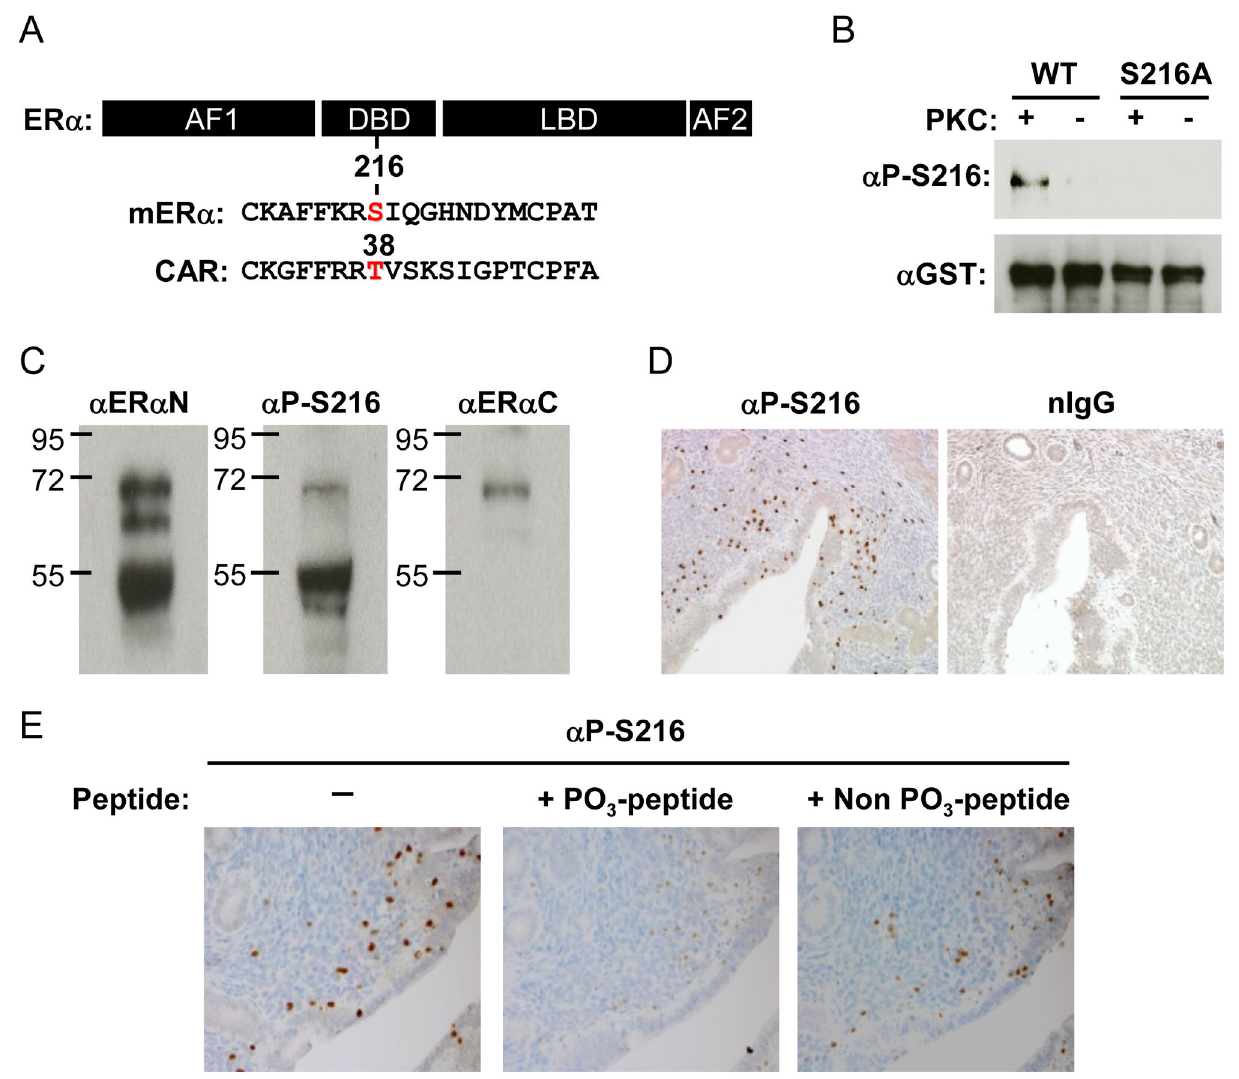
Figure 1. Phosphorylation of ERα at serine 216. (A) Map to show localization of serine 216 in ERα and threonine 38 in CAR. (B) In vitro phosphorylation of serine 216. Purified glutathione S transferase (GST)-mERα wild type (WT) and GST-S216A were incubated with or without protein kinase C (PKC) and Western blots were performed using an anti-P-Ser-216 (αP-S216) or